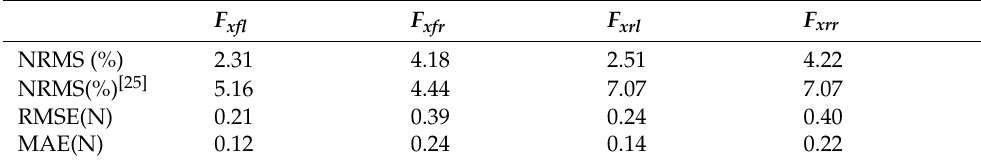
Table 5. The longitudinal force estimation error.